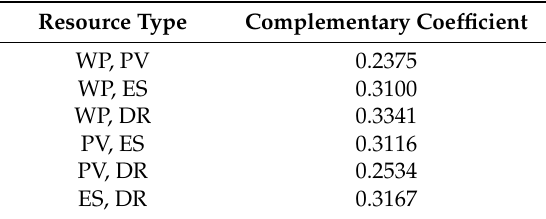
Figure 10. Daily characteristics curve of various resources. Table 4. Complementary coefficients of various resources.